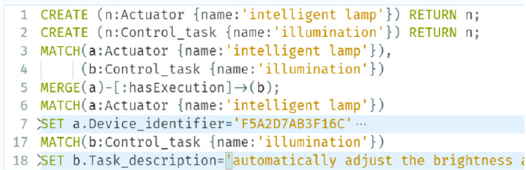
Figure 13. The process of device twin creation.